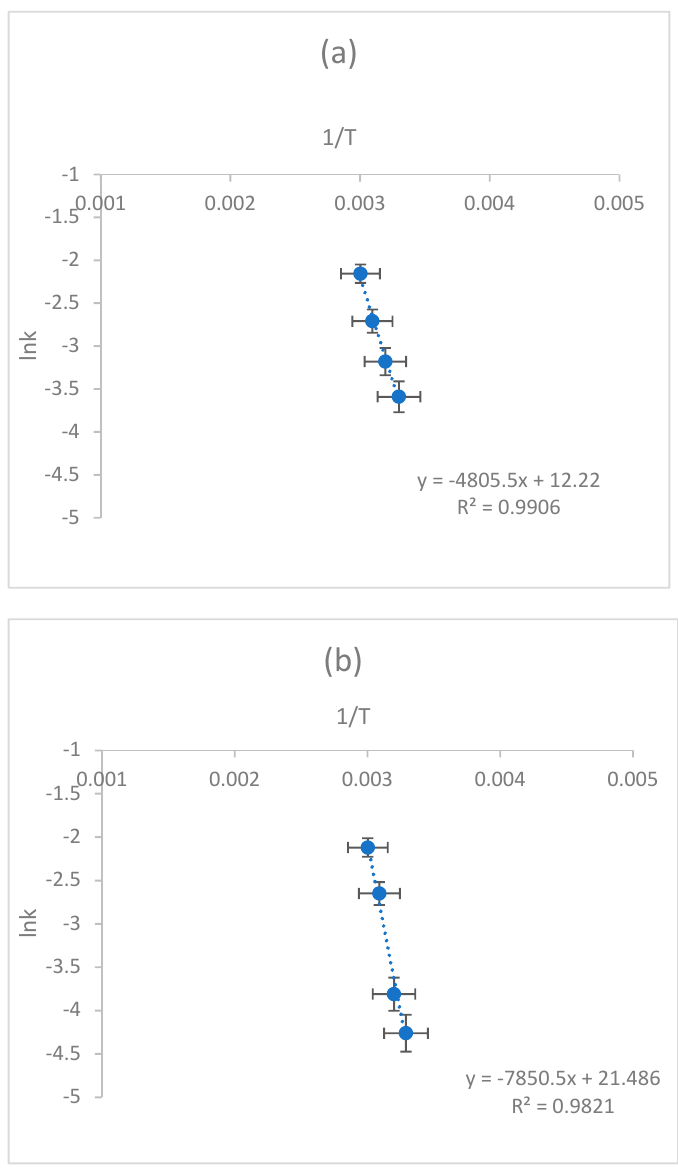
y = -4805.5x + 12.22 R² = 0.9906